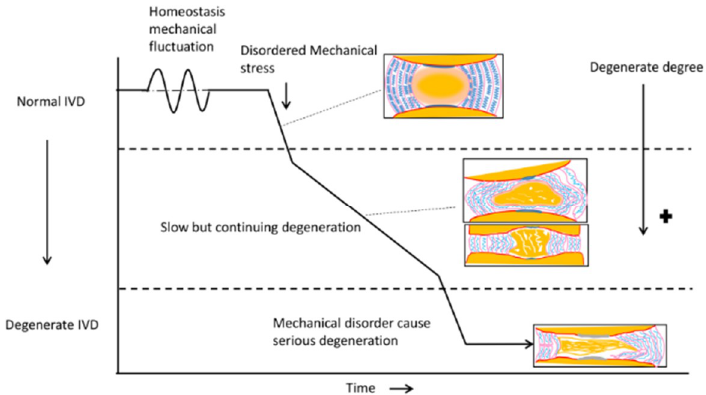
Figure 2. Disordered mechanical stress causes IVD degeneration. There are some mechanical fluctuations in normal IVD. Imbalance in the normal homeostatic mechanics due to mechanical disorder initiates IVD degeneration. Early stages of IVD degeneration is represented by a bulging nucleus pulposus (NP) and discrete AF. Slow but continuing degeneration results in white consolidated fibers in the NP from.